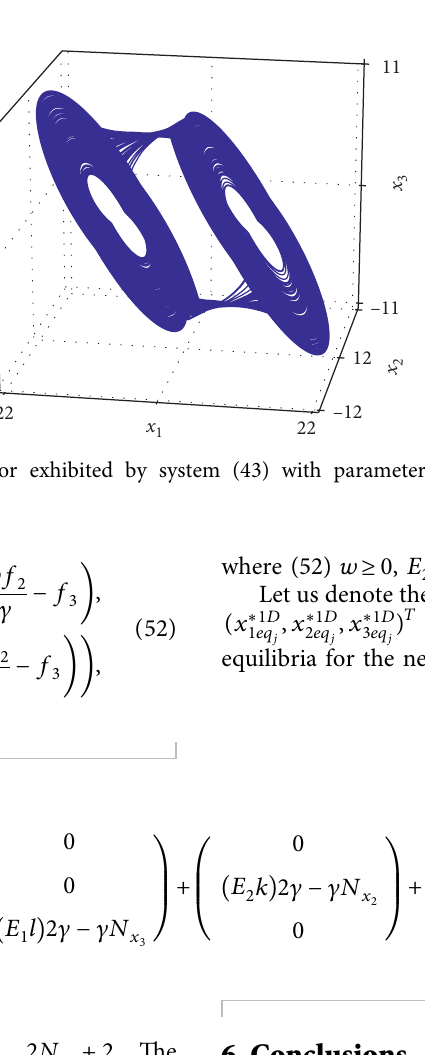
Figure 5: Cut of basins of attraction of system (43) with parameters a � 0 . 2, b � 5, c � − 7, and N to the basins of attraction of self-excited attractors, and blue dots belong to the basin of attraction of the hidden attractor. In (a) grid of 0.5 and in (b) and (c) grid of 0.1.